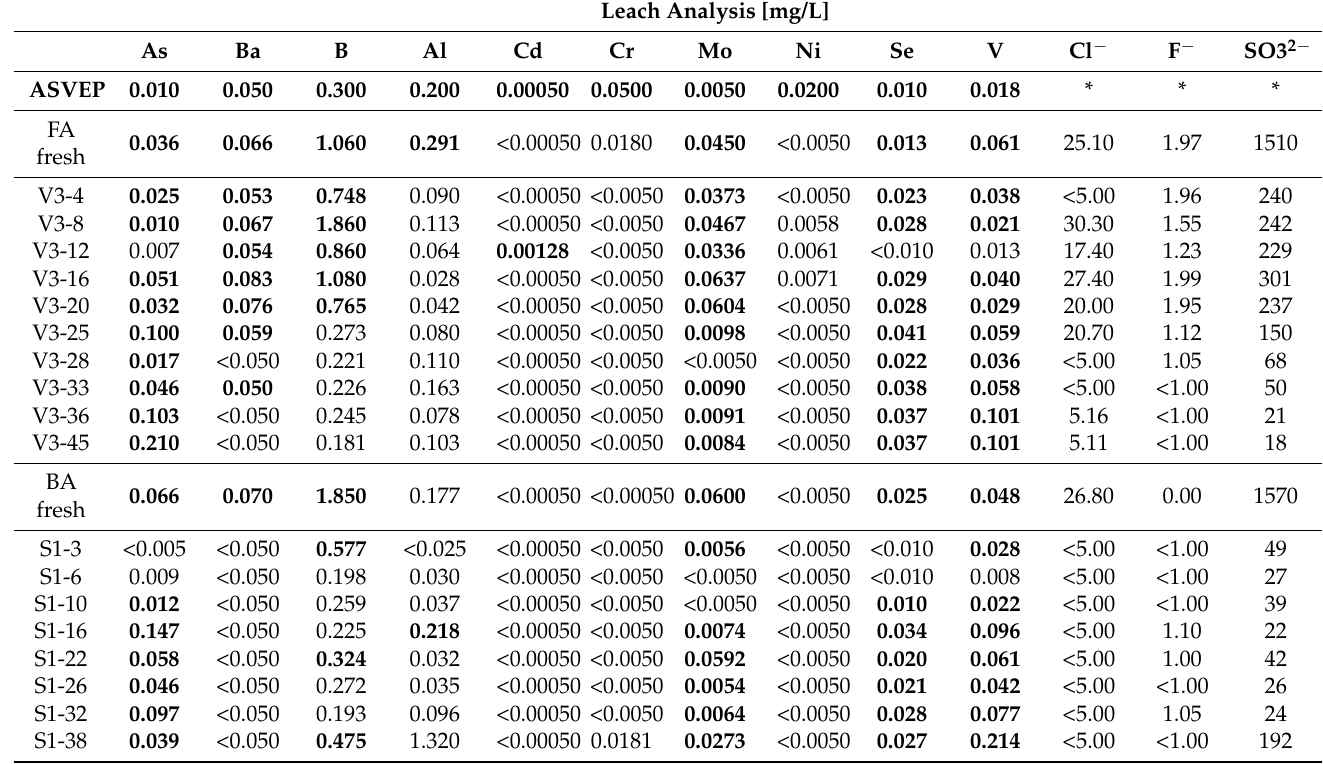
Table 4. Leachability Analysis of Trace Elements in Fresh FA, BA and in Samples from Core Boreholes V3 and S1. Measurement errors were below 1